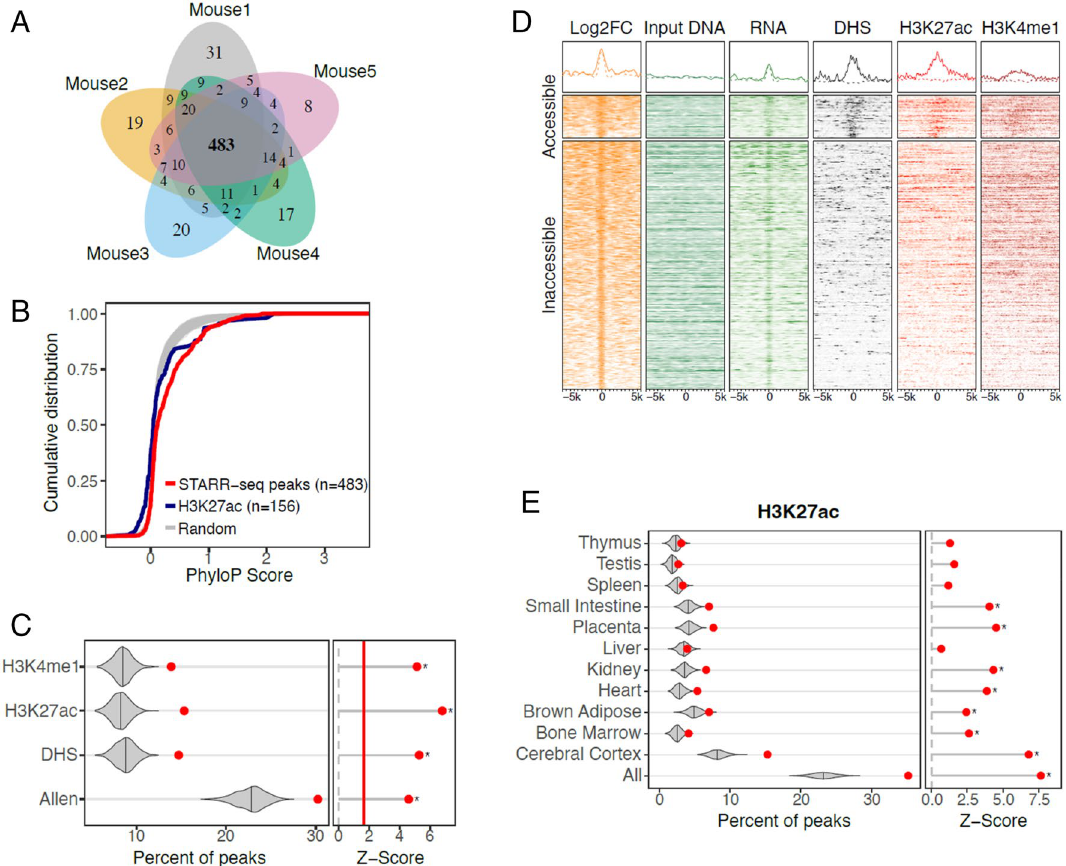
Figure 2. Candidate enhancer identification. ( A ) Reproducibility across mice of the RNA/input DNA peaks called by the STARRPeaker algorithm. Plotted is the number of mice in which a given peak has been identified. Note, that the majority of peaks were identified in all five mice independently. ( B ) Cumulative distribution of PhyloP evolutionary conservation scores of the candidate enhancer peaks (red line) compared with 1000 randomly shuffled control peak sets (grey lines), indicating an increased conservation of AAV-STARR-seq peaks. For comparison, the cumulative distribution of H3K27ac marks within the screened genomic regions is shown (blue line). ( C ) Overlap of candidate enhancer peaks with active enhancer-associated histone marks (H3K4me1 and H3K27ac) and accessible chromatin regions in adult mouse brain cortex (red dots), compared with 1000 shuffled controls (violin plots). The right panel lollipop plot shows the Z-scores of the real overlap based on fitting a normal distribution to the random controls. Asterisks indicate significant differences based on empirical p < 0.05. DHS: Dnase1 Hypersensitive Site dataset from the ENCODE project; Allen: Pooled neuron subtype-specific ATAC-seq peak datasets from the Allen Brain Atlas. ( D ) Heatmap showing the input DNA, merged RNA and the corresponding RNA/DNA log2 fold change signal around the STARR-seq peaks (rows), as well as the accessible chromatin, H3K27ac and H3K4me1 histone mark signal from adult mouse cortex. The heatmap is clustered into STARR-seq peaks overlapping accessible chromatin peaks (above) and non-overlapping peaks (below), and sorted by RNA/DNA log2 fold change (STARR column). ( E ) Overlap of candidate enhancer peaks with H3K27ac active enhancer-associated histone marks in several adult mouse organs. Violin and lollipop plots are created as in (C). Asterisks indicate significant differences based on empirical p <